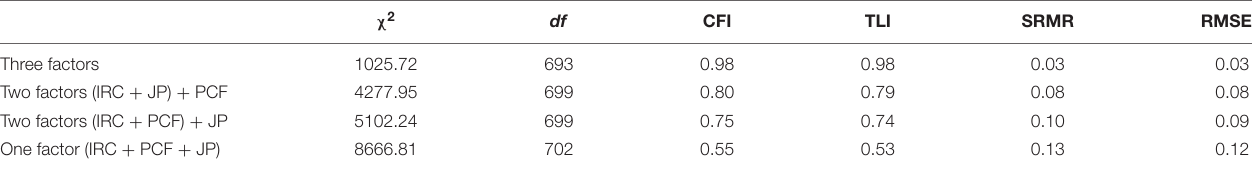
TABLE 2 | Results of confirmatory factor analysis.